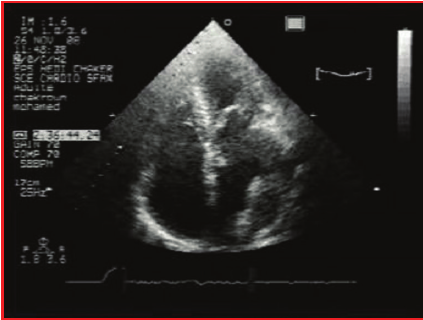
Figure 1: Transthoracic echocardiography: 4 chambers view show- ing a well-circumscribed mass in the let atrium.